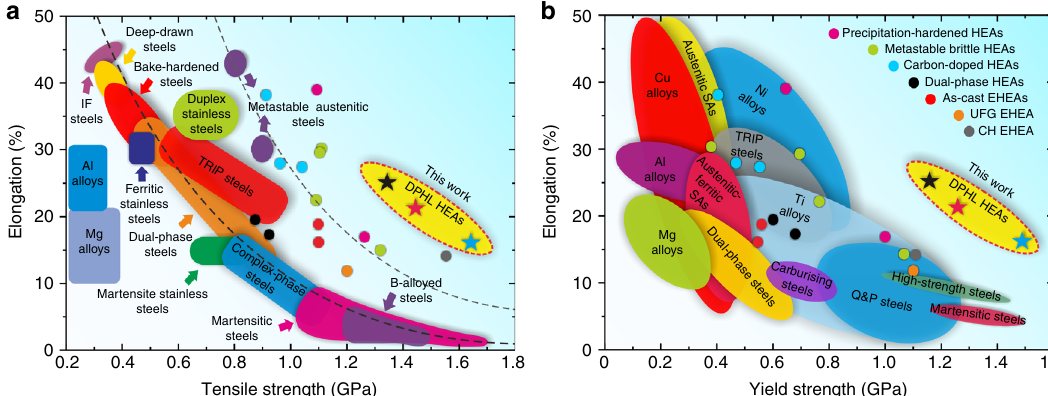
Fig. 5 Tensile properties of the hierarchical DPHL HEAs in comparison with the traditional metallic materials and the previously-reported hardened HEAs. a , b A general summary of the fundamental tensile properties at ambient temperature. Note that the reported HEAs, including the as-cast EHEA 12,13 , ultra fi ne-grained (UFG) EHEA 7 , complex and hierarchical (CH) EHEA 23 , dual-phase HEAs 33 , metastable brittle HEAs 4 , precipitation-hardened HEAs 32 , and carbon-doped HEAs 31 , are the products of several of the most effective strengthening mechanisms among HEAs in general, but they only show the better tensile strength – ductility synergy, in comparison to traditional alloys. There, of course, are a few advanced HEAs not shown for comparison, due to their low yield strength (for example,< 400 MPa) 35 and poor room-temperature